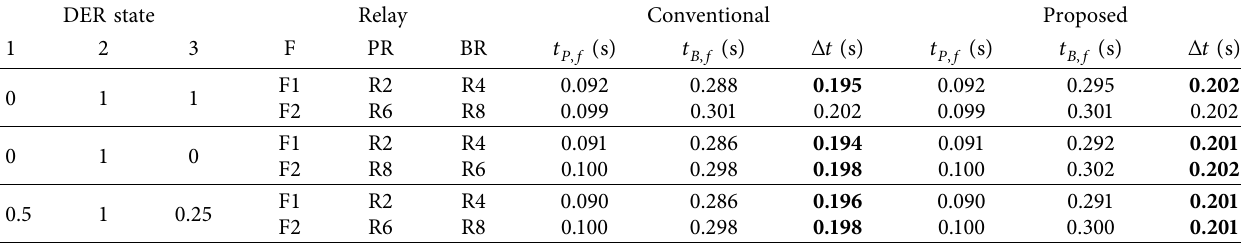
Table 6: Operating times for the islanded